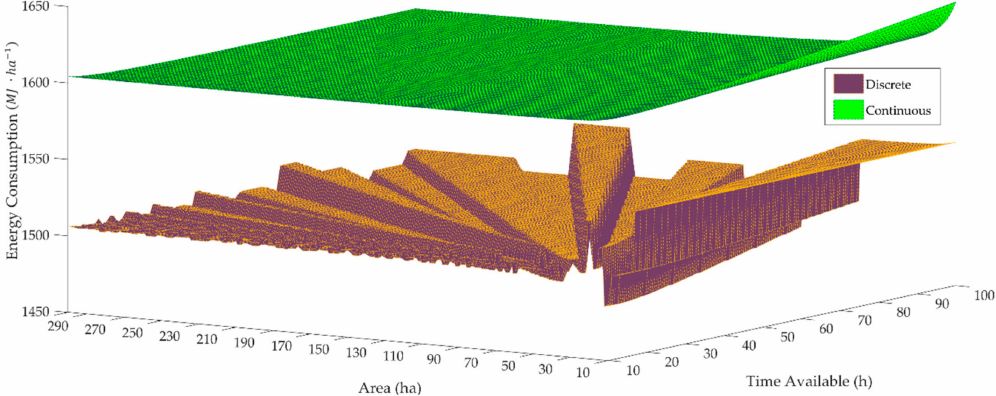
Figure 9. Energy consumption model for moldboard